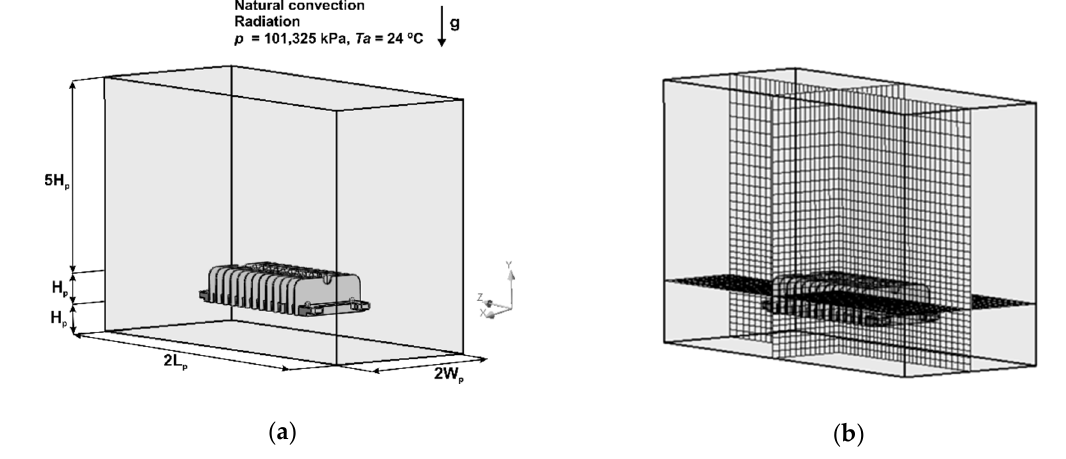
Figure 8. Simulation model of the LED panel: ( a ) computation domain with the assumed boundary conditions and ( b ) cross-section of the computation grid along the XYZ axis.